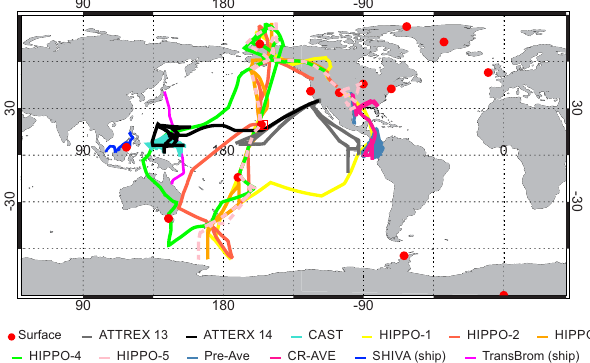
Figure 2. Summary of ground-based and campaign data used in TransCom-VSLS. See main text for